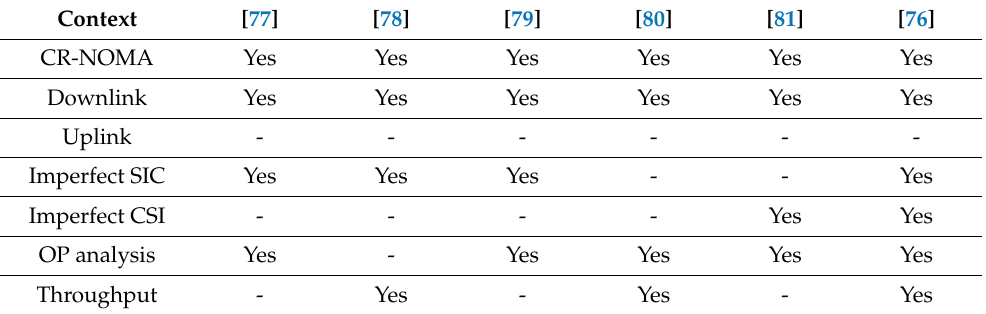
Table 3. Comparison of studies reported on SCI/CSI in NOMA